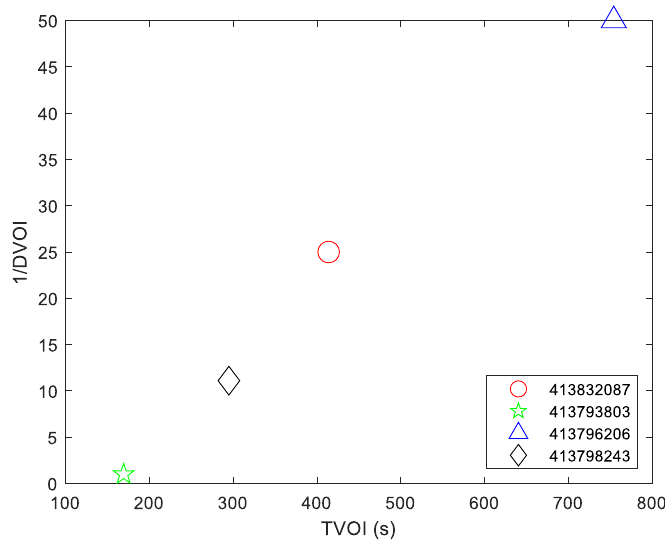
Figure 18. Pareto ranking of ship risk indicators in Case 4.